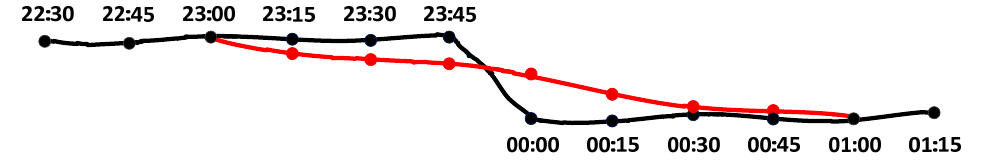
Figure 2. Comparison between the original product and the calibrated product near the daily boundary. The plotted colors for the original and calibrated products black and red, respectively.